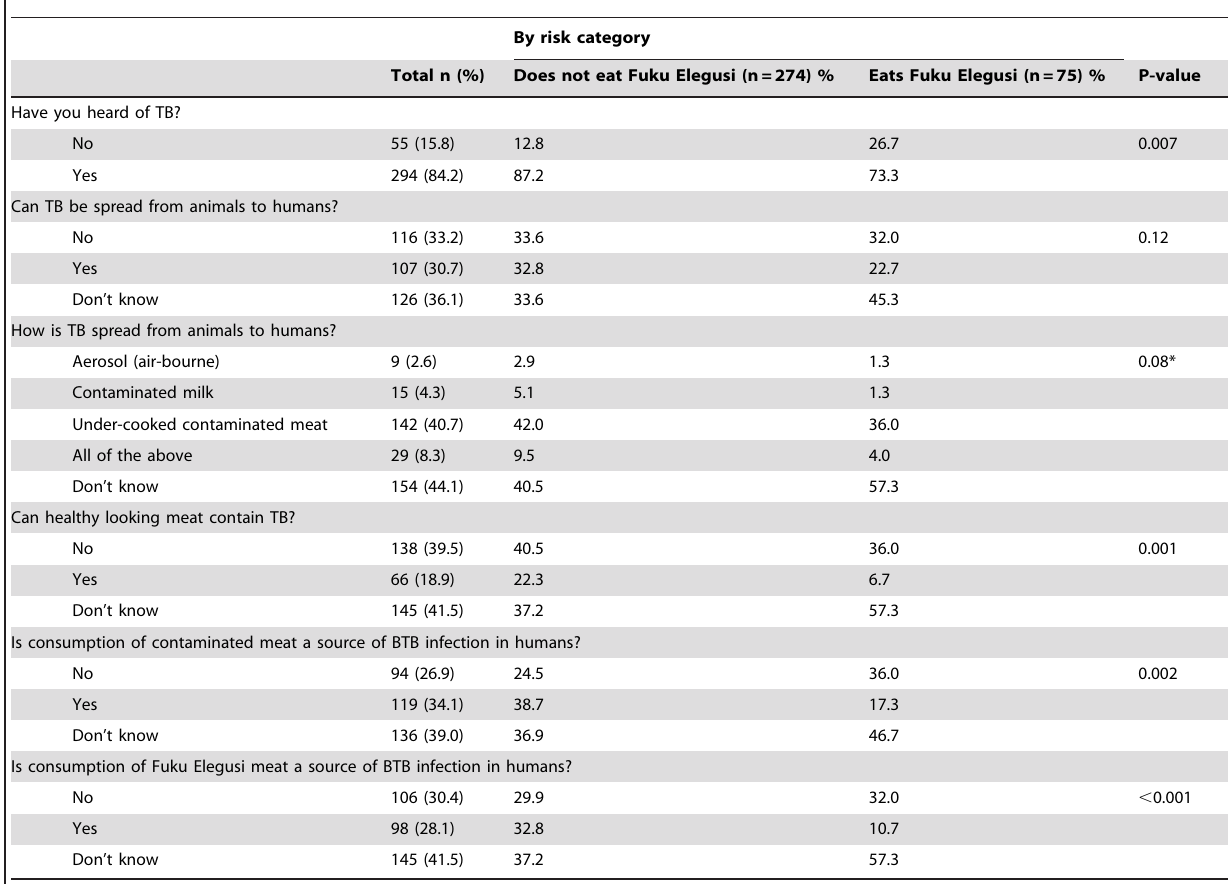
Table 3. Knowledge of BTB, by risk category (n=349).